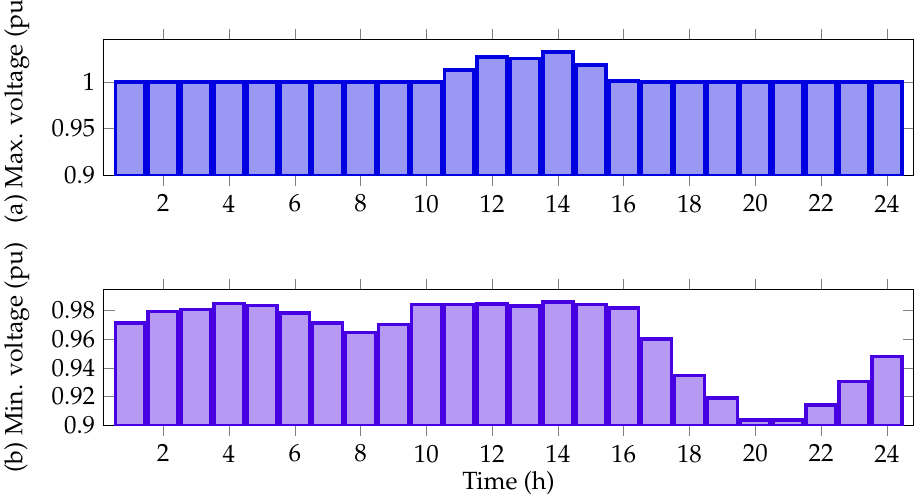
Figure 6. Voltage behavior during one day in the 33-node test system: ( a ) maximum voltage and ( b ) minimum